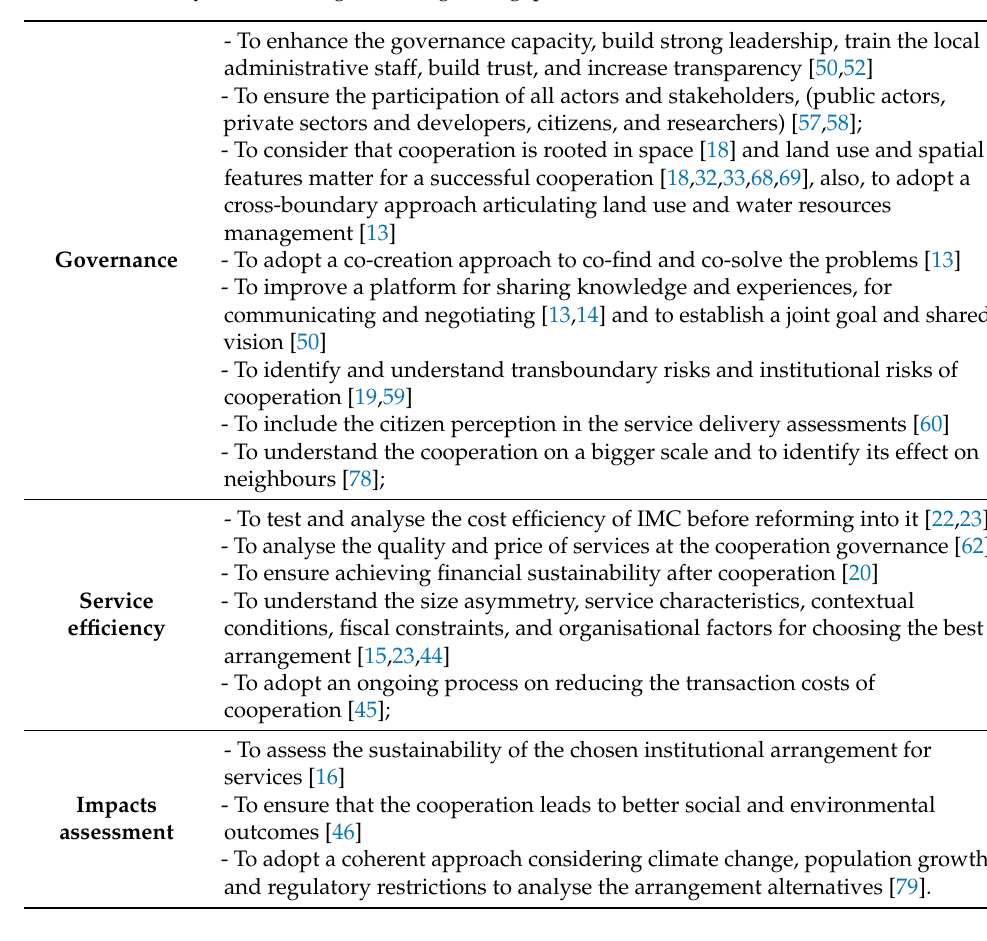
Table 6. Summary of the findings: learnings and gaps from IMC and